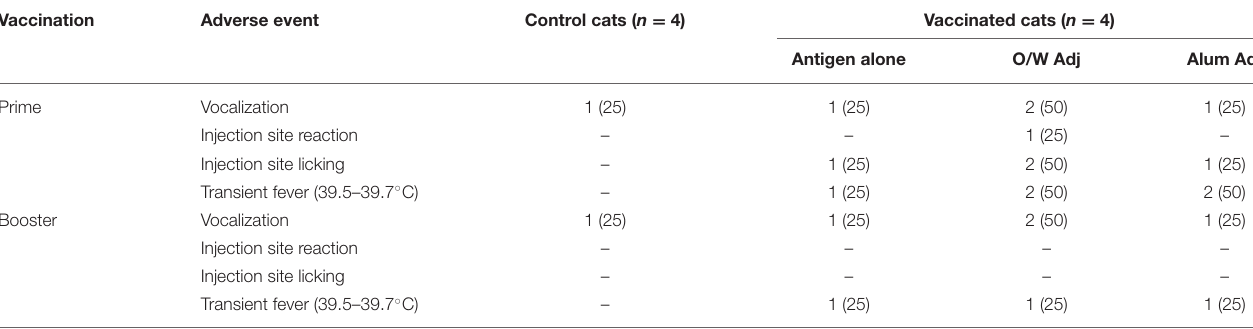
TABLE 2 | Frequency of immediate local reactions and transient fever within each treatment group.